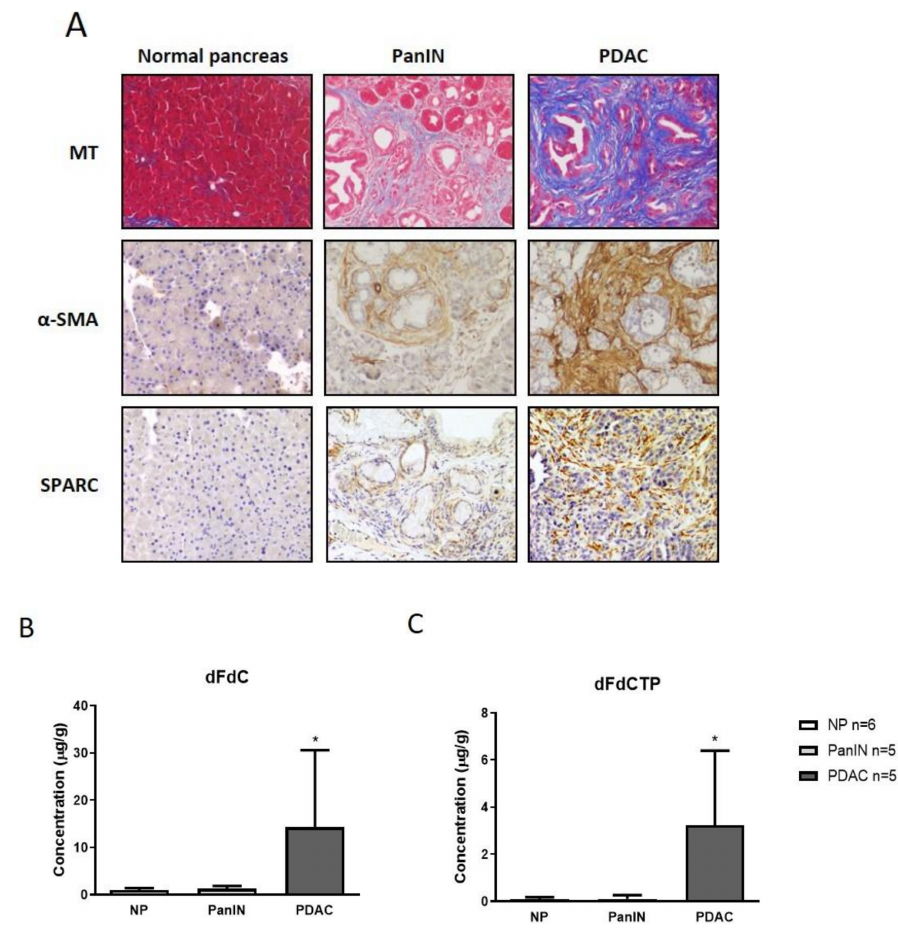
Figure 1. ( A ) Representative Masson trichrome (MT) and immunohistochemical stainings for alpha-smooth muscle actin ( α -SMA) and secreted protein acidic and rich in cysteine (SPARC) in normal murine pancreas, murine pancreatic intraepithelial neoplasia (PanIN) and pancreatic ductal adenocarcinoma (PDAC) tissues from LSL-Kras G12D /+ ; p48 -Cre (KC) mice showing progressive desmoplastic features. ( B , C ) KC mice and control B6 mice were treated with one dose of gemcitabine at 100 mg / kg intraperitoneally. Tumor tissue ( n = 5 mice), PanINs ( n = 5 mice) and normal pancreas (NP; n = 6 mice) were assessed for gemcitabine metabolites 2 h later by liquid